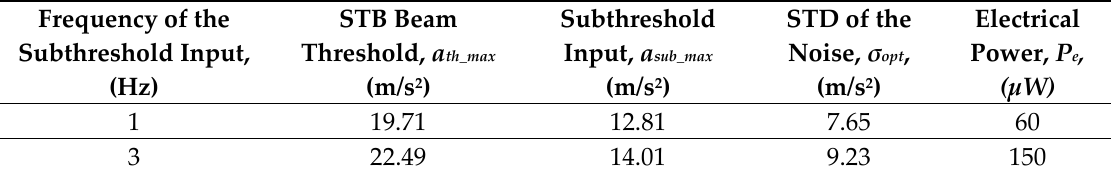
Table 1. Information about the threshold acceleration, a th_max , the subthreshold acceleration of the adopted periodic input, a sub_max , the STD of the optimal noise, σ opt , and the electrical power, P e , measured on a resistive load of 15 k Ω